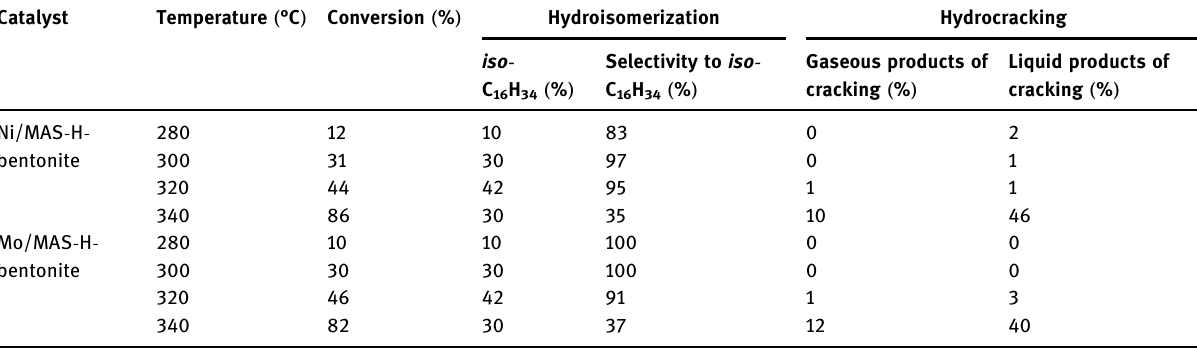
Table 3: Catalytic performance of Ni/MAS - bentonite and Mo/MAS - bentonite bifunctional catalysts based on MAS in the process of n - hexadecane hydroisomerization